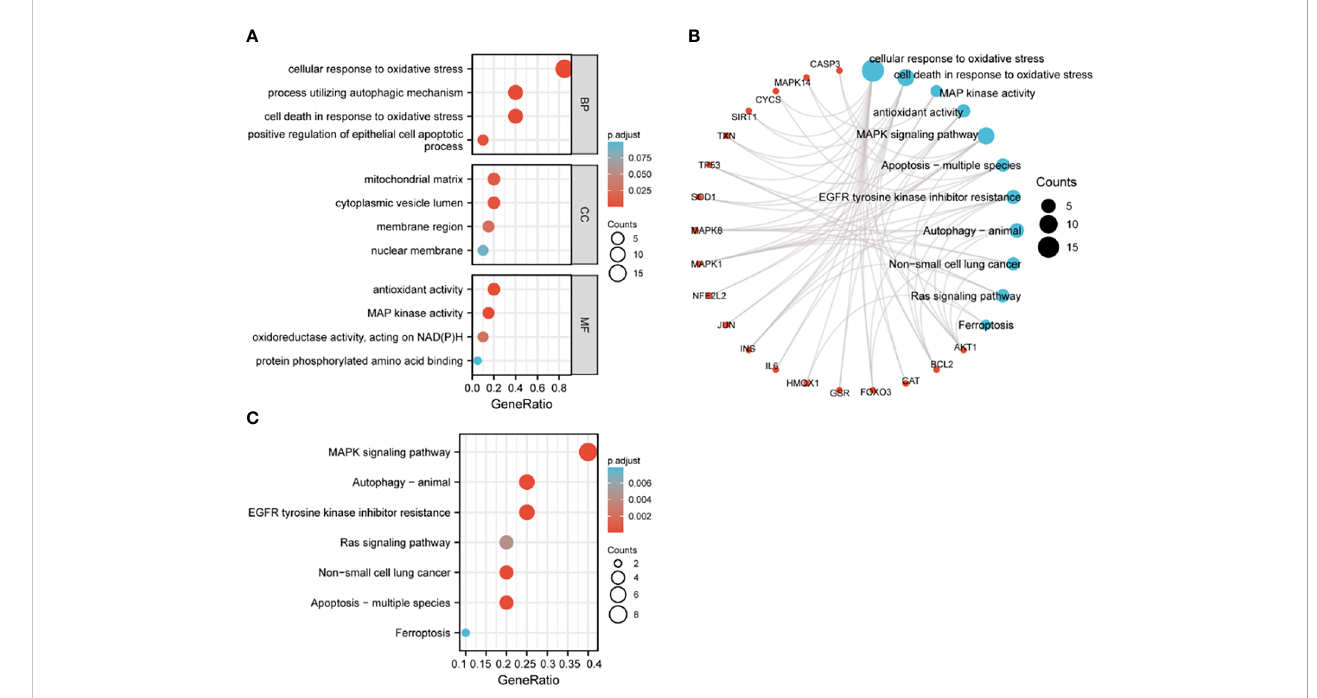
FIGURE 5 GO and KEGG enrichment analysis of hub genes. (A) GO analysis; (B) circular diagram of GO and KEGG analyses; (C) KEGG